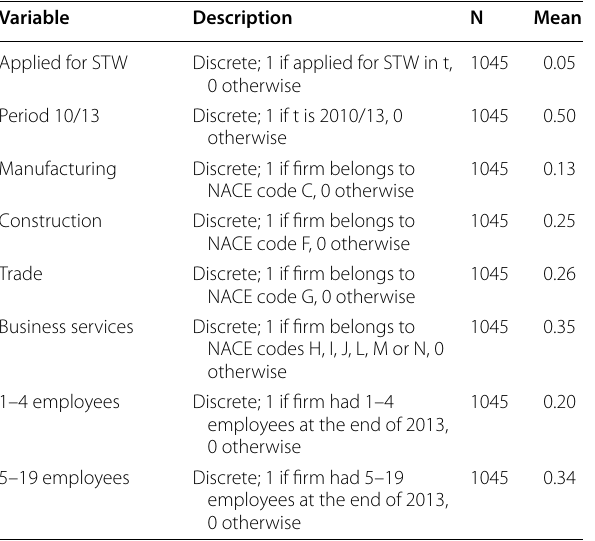
Table 8 Variables definition and summary